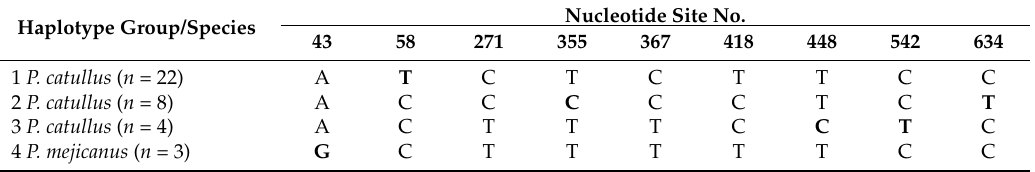
Table 2. Variable nucleotide sites in the 658 bp COI barcode segment showing apparent fixed differences among samples of Pholisora catullus and P. mejicanus . For P. mejicanus at site 448, n = 2; for P. catullus at site 634, n = 21 for group 1 and n = 4 for group 2. Nucleotides shown in red are diagnostic for the haplotype group/species indicated. All substitutions are third codon position transitions, except at site 542 (first codon